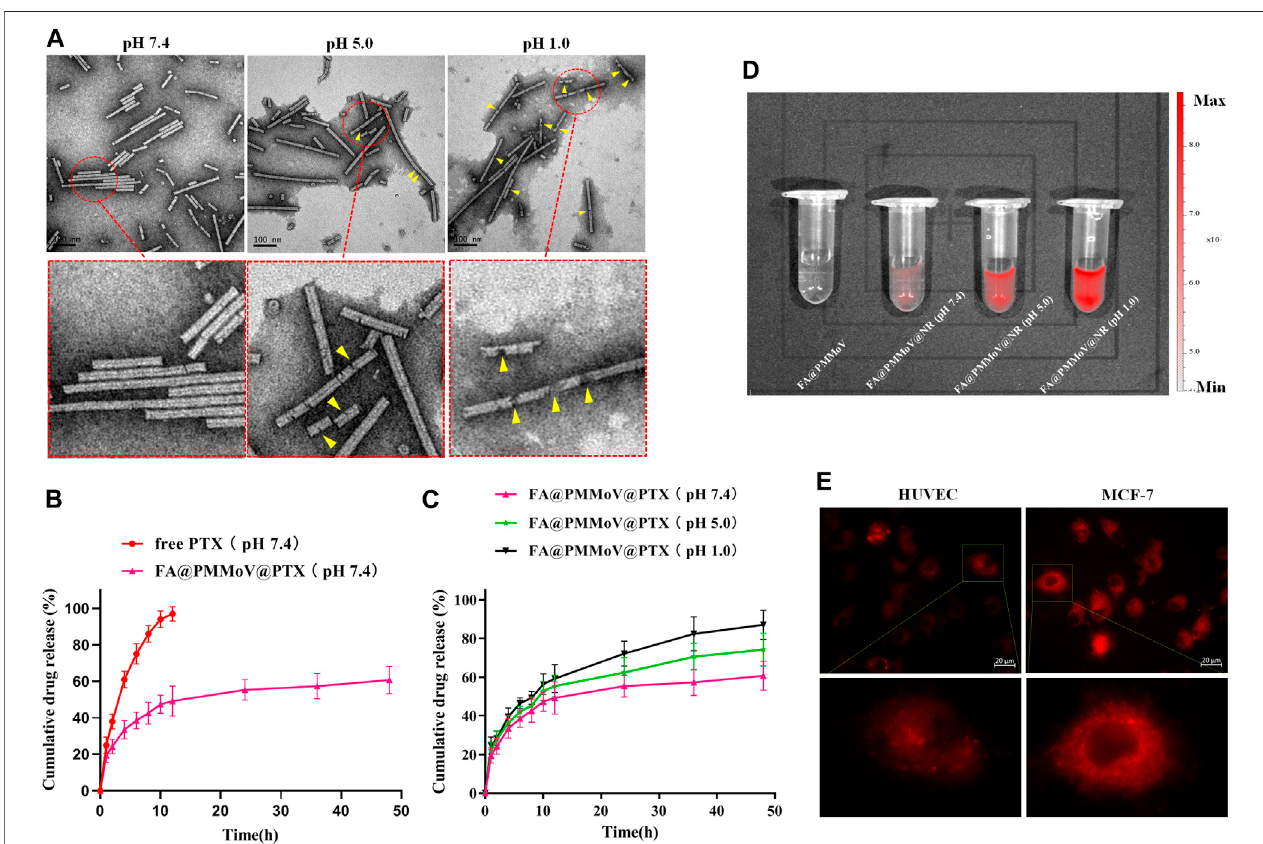
FIGURE 2 | Characterization of FA@PMMoV@PTX nanotubes. (A) TEM images of FA@PMMoV@PTX nanotubes after incubation in media at different pH values. (B) The invitro drugreleaseofFA@PMMoV@PTXnanotubesinpH7.4medium,usingfreePTXasacontrol. (C) The invitro drugreleaseofFA@PMMoV@PTXnanotubes in media at pH 7.4, 5.0, and 1.0. (D) Images showing the fl uorescence of FA@PMMoV@NR nanotubes after incubation in media at different pH values. (E) Images showing the fl uorescence of FA@PMMoV@Dir nanotubes in MCF-7 cells and HUVEC